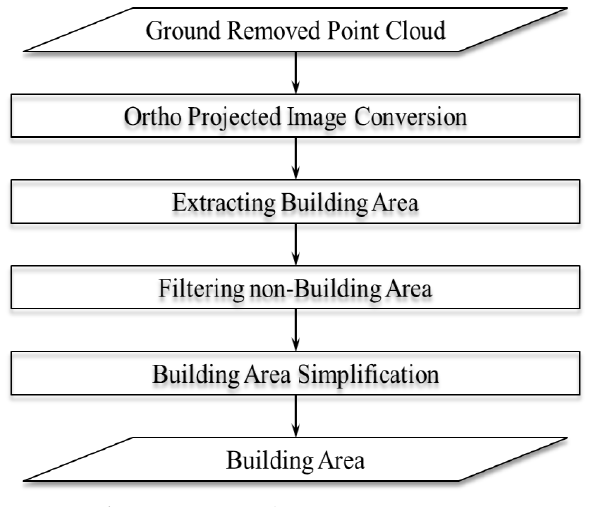
Figure 6. Ground removed point cloud(a) and initial building area in ortho image.